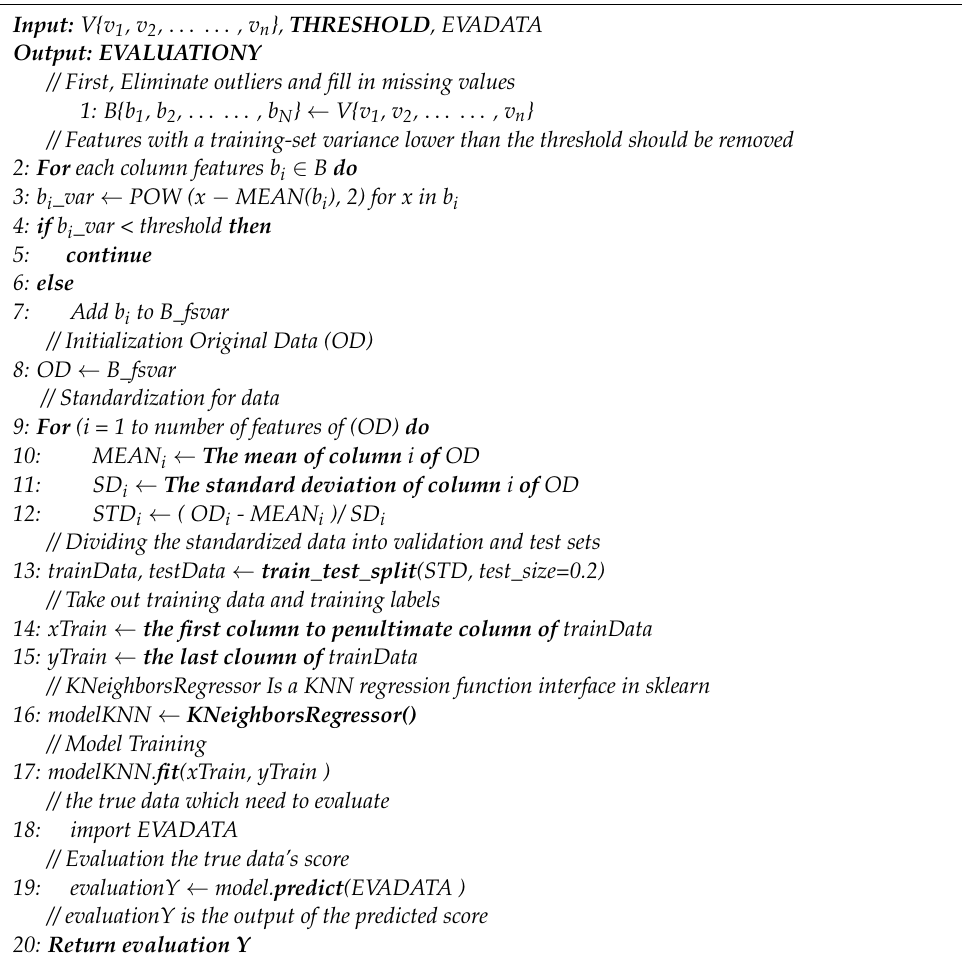
Algorithm 1. Procedual evaluator of students’ practical operation